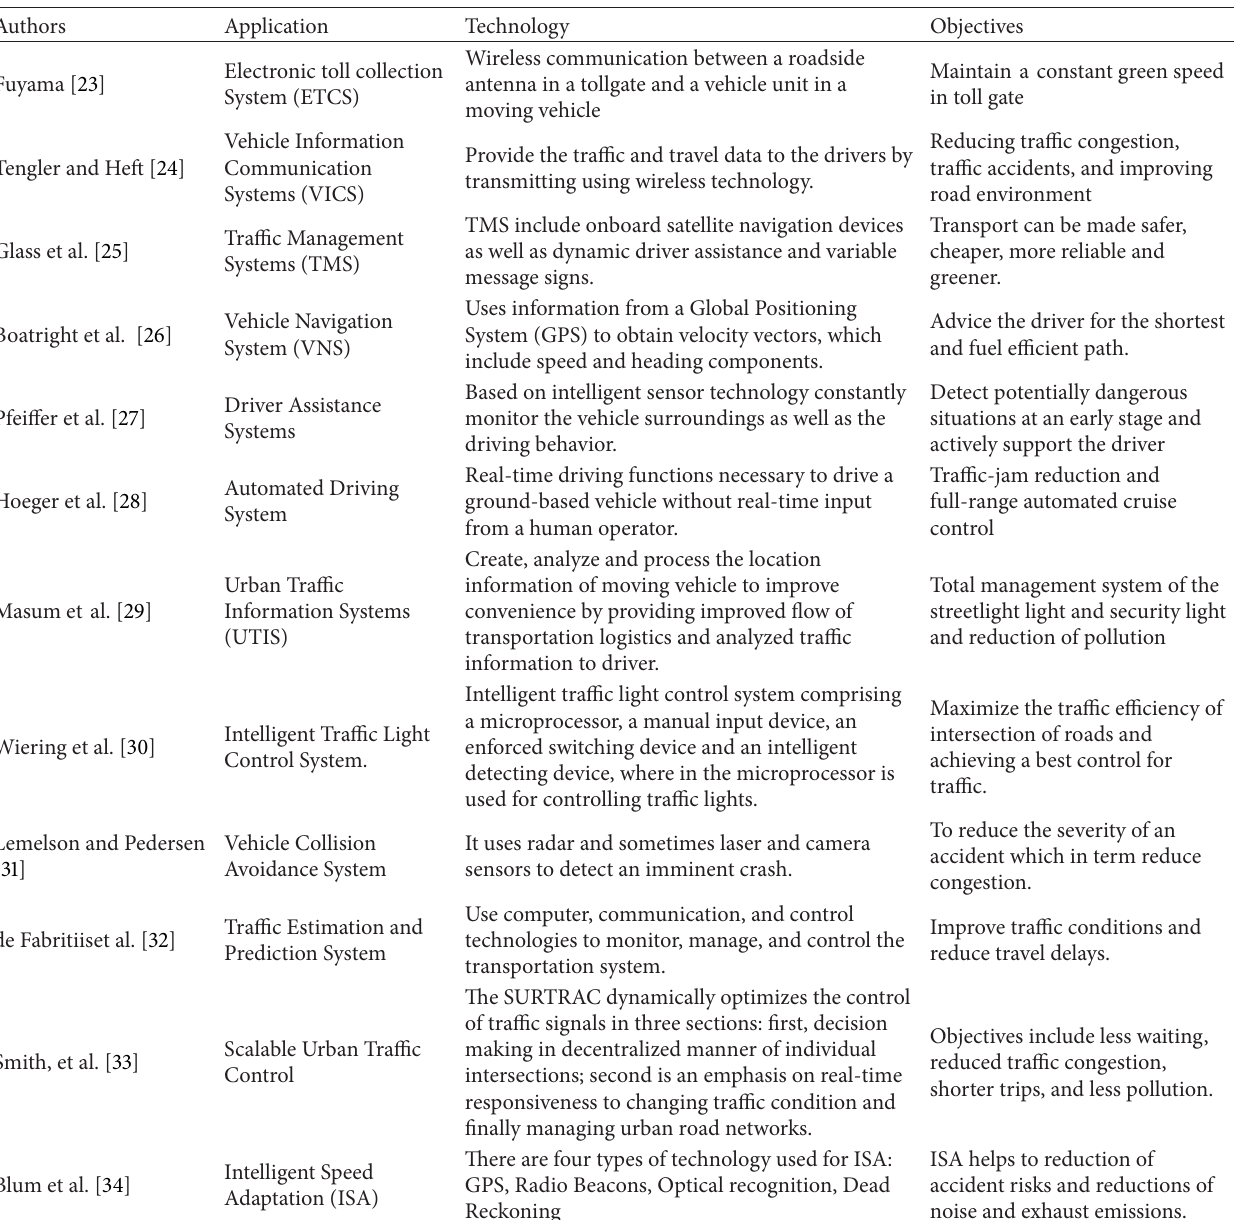
Table 2: Summary of ITS